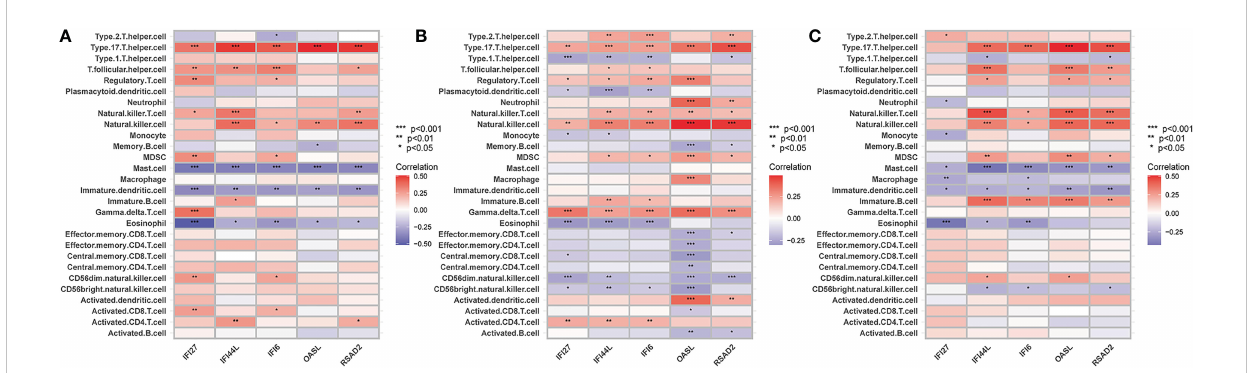
FIGURE 11 (A) The correlation between hub genes-immune cells and the fraction of in fi ltrated immune cells in COVID-19, (B) The correlation between hub genes-immune cells and the fraction of in fi ltrated immune cells in H1N1, (C) The correlation between hub genes-immune cells and the fraction of in fi ltrated immune cells in In fl uenza. *p < 0.05, **p < 0.01, ***p <